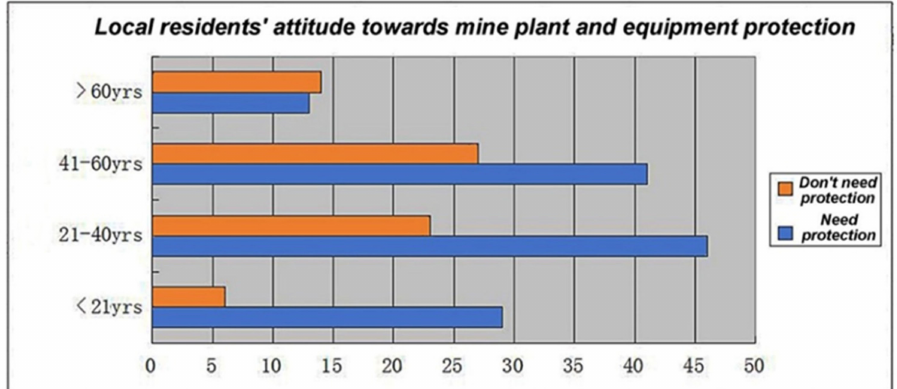
Figure 13. Residents’ attitude towards the protection of mines and